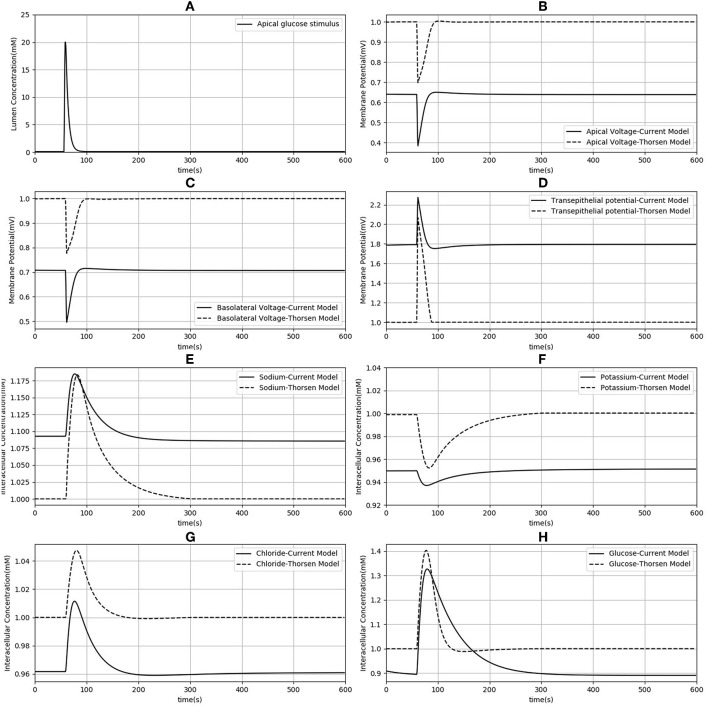
Comparison of model responses against the model of Thorsen et al. (2014). Each variable has been normalized against the corresponding steady value from the Thorsen model. (A) Apical glucose stimulus. (B,C) Apical and basolateral membrane potential respectively. (D) Transepithelial potential. (E–H) Sodium, potassium, chloride and glucose intracellular concentration.